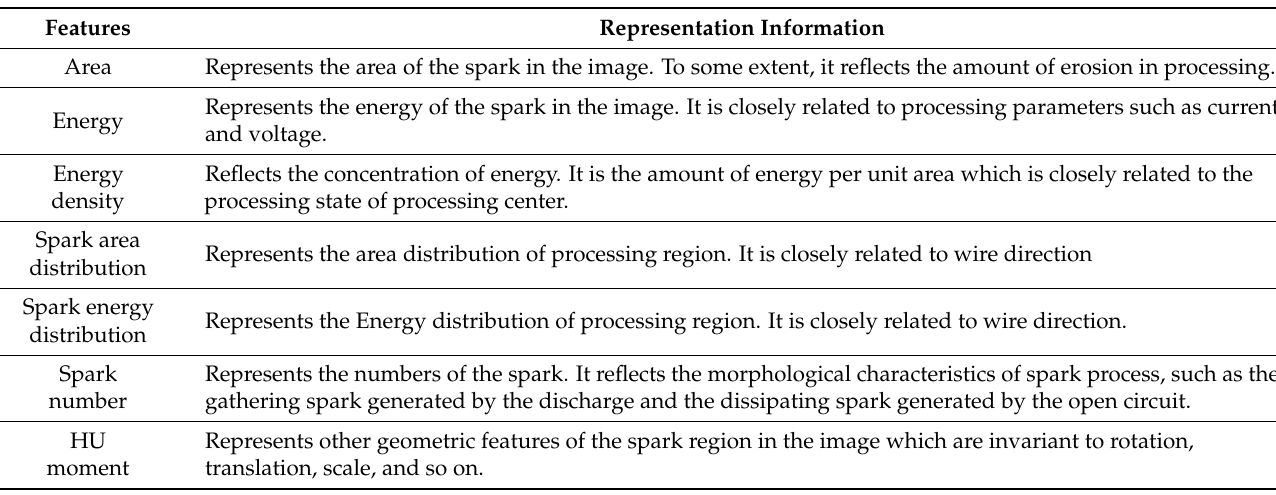
Table 1. Features and representation